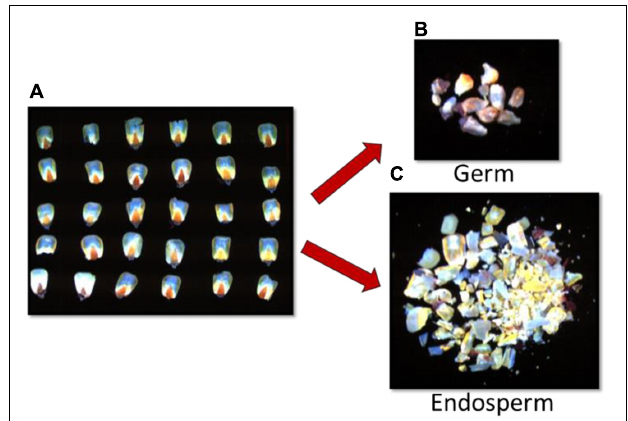
FIGURE 3 | Fluorescence images of (A) corn kernel cross-sections inoculated with toxigenic and atoxigenic strains of A. flavus (AF13 and AF36), separated and grouped into (B) germ and (C)